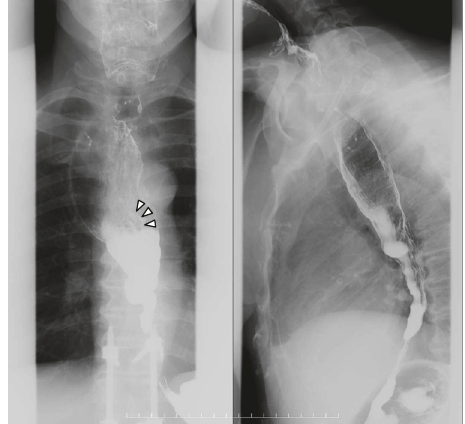
Figure 2: Barium esophagram showed esophageal dilation with a gradual tapering down to the gastroesophageal junction. There was a superficial protruding lesion in the midthoracic esophagus (arrowhead).